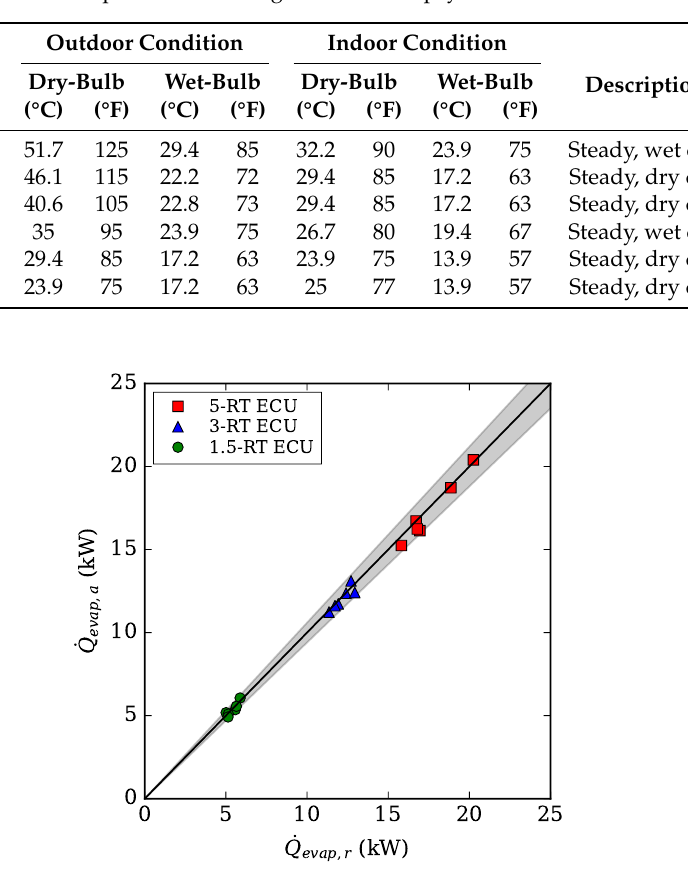
Figure 4. Parity plots comparing the cooling capacity between the air-side and the refrigerant-side for 1.5-RT, 3-RT, and 5-RT